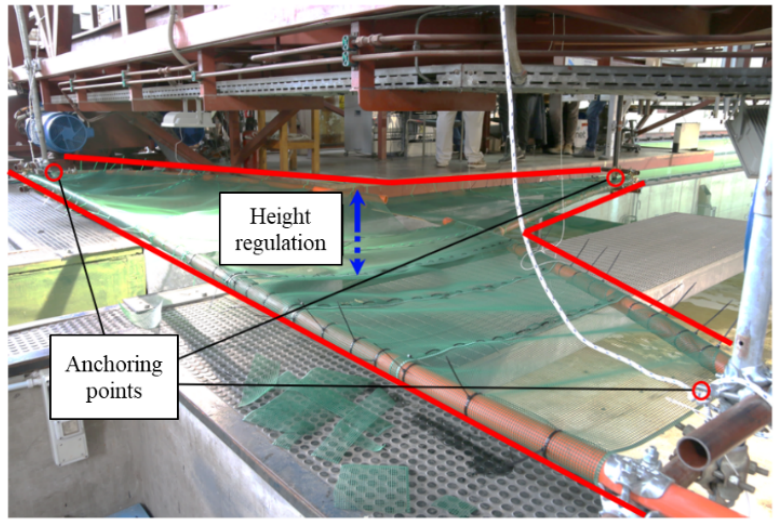
Figure 7. Artificial seabed